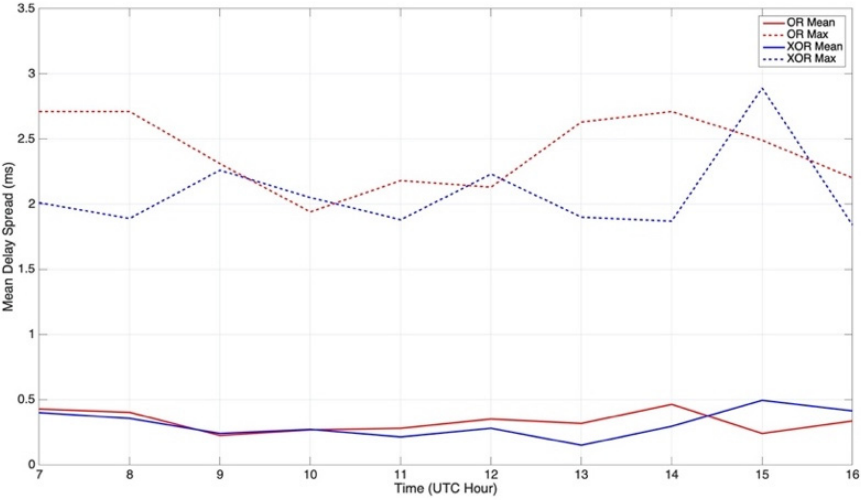
Figure 11. NVIS delay spread vs. time of the NVIS channels.